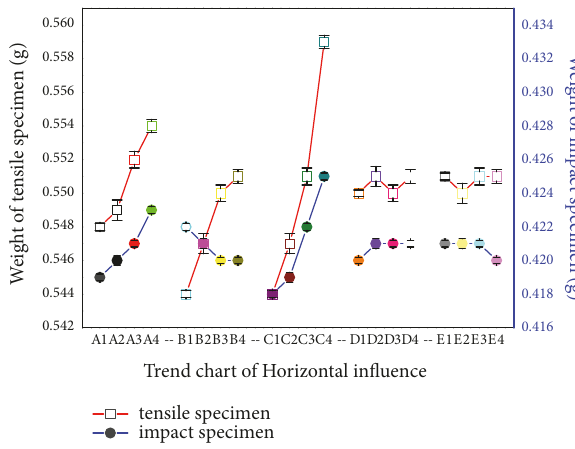
Figure 3: Horizontal trend chart of tensile and impact specimen .